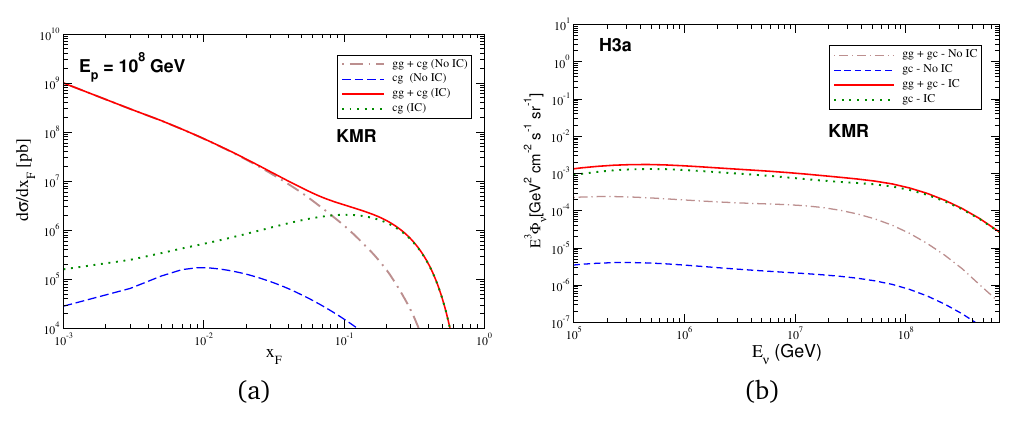
Figure 1: Predictions of the hybrid model for (a) the Feynman x charm particles and (b) the prompt neutrino flux (rescaled by E 3